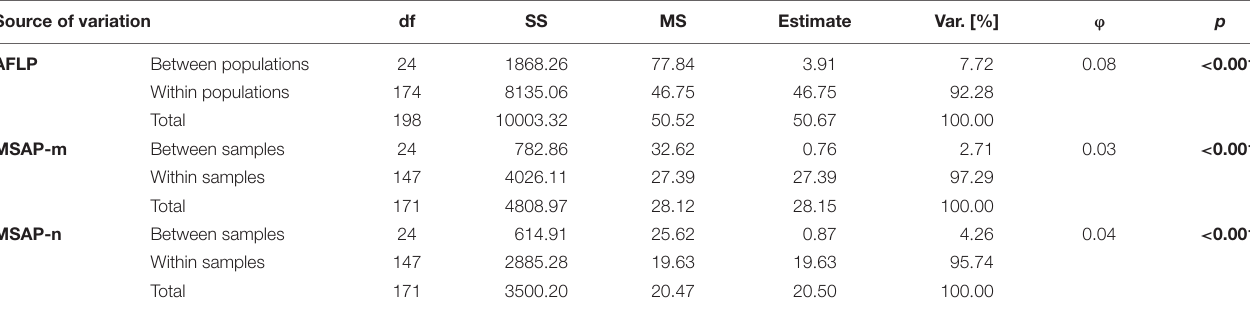
TABLE 1 | Analysis of molecular variance from genetic (AFLP) and epigenetic (MSAP-m, MSAP-n) datasets. Source of variation df SS